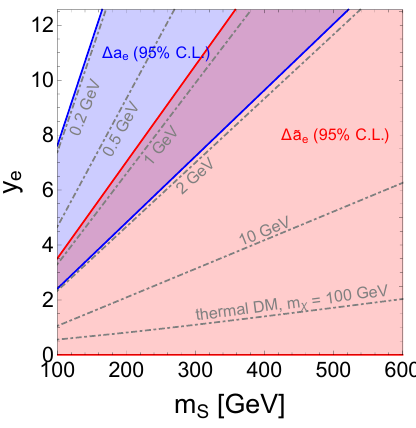
Figure 11 . The interplay between ( g − 2) e and thermal DM requirements. In blue (red) shaded region, we show the range for y gray dotdashed lines shows the thermal y th between 1 GeV and 2 GeV can simultaneously explain ( g − 2)